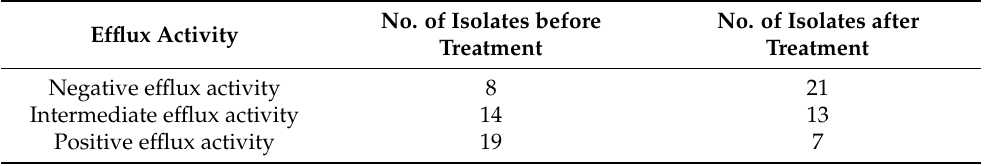
Table 2. Efflux activity of MRSA isolates, measured by EtBr cartwheel method, before and after treatment with DEEL.